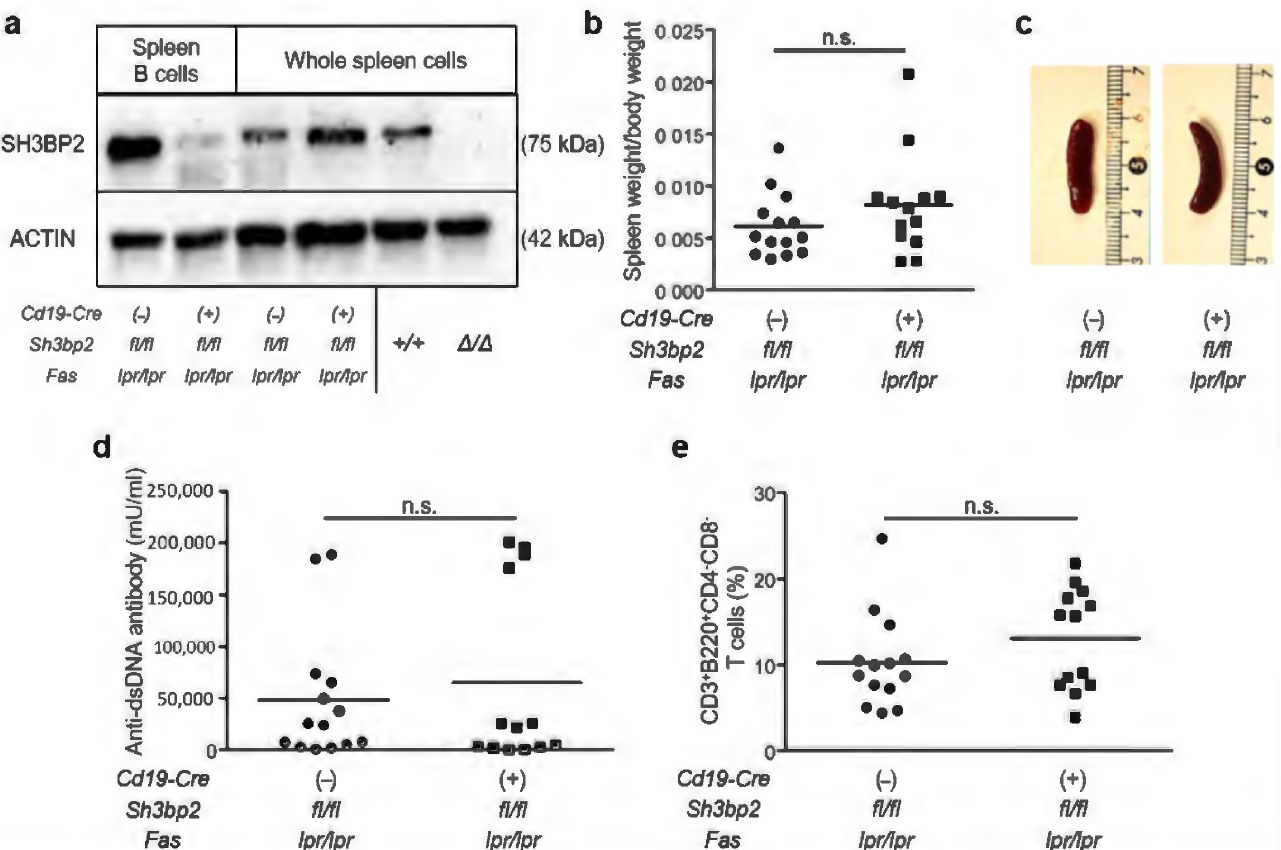
Figure A4. B cell-specific deletion of SH3BP2 does not modulate phenotypes of Fas lpr/lpr lupus-prone mice. ( a ) Immunoblot analysis for SH3BP2. Protein samples were collected from the indicated mice. SH3BP2 protein levels were determined by western blotTable 19. Sh3bp2 fl/fl Fas lpr/lpr ( n = 14) and Cd19 Cre/+ Sh3bp2 fl/fl Fas lpr/lpr ( n = 13) mice were monitored until the age of 35 weeks. ( b ) At the end of the observation period, spleen weights per body weights were determined. ( c ) Representative images of the spleens. ( d ) Levels of serum anti-dsDNA antibody were determined by ELISA. ( e ) Flow cytometry for T cell subsets in the spleen. The ratios of CD3 + B220 + CD4 - CD8 - cells (double negative T (DNT) cells) subsets were analyzed. All the cells were gated on lymphocytes. Each dot denotes an individual mouse, and horizontal lines represent the means. n.s. = not